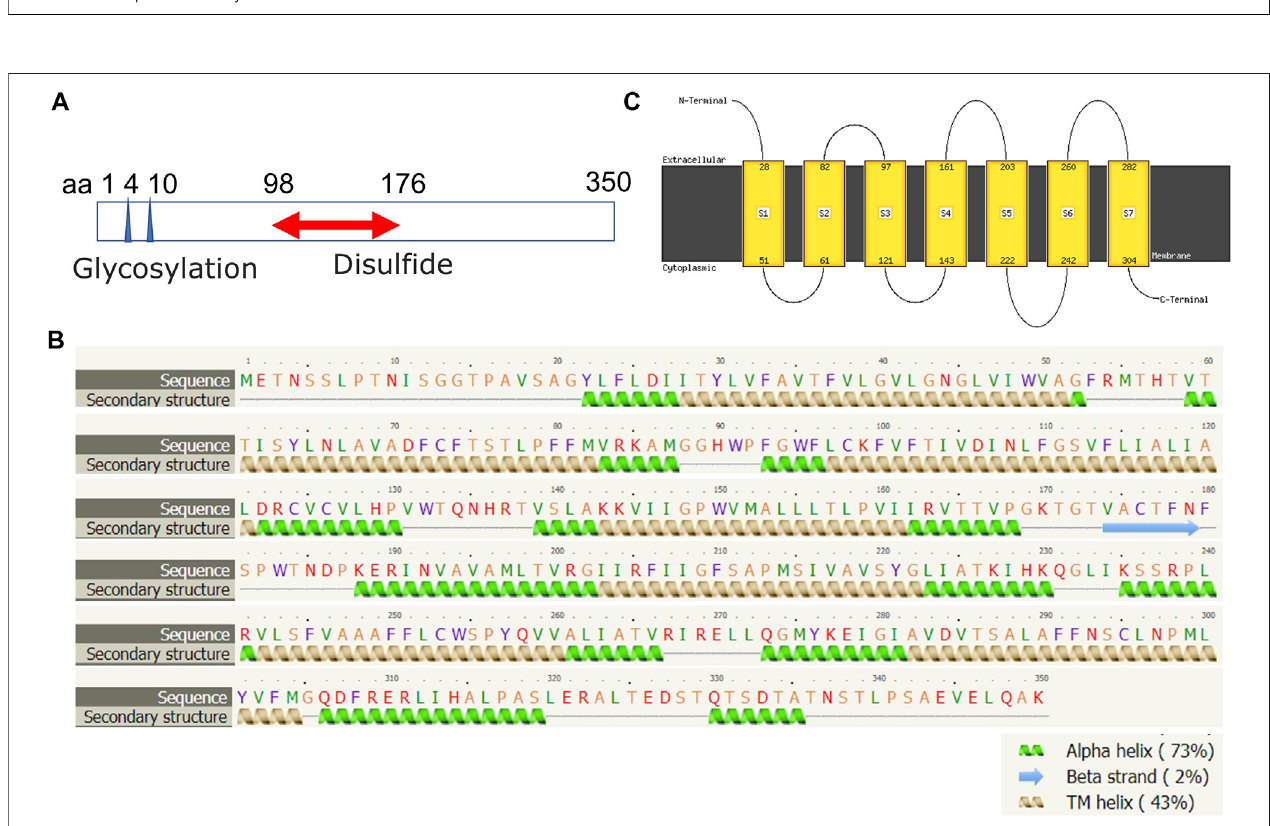
FIGURE7| MolecularstructuralanalysisofFPR1.MolecularstructureofFPR1,predictedbybioinformaticsinformationbasedon (A) Uniprot(https://www.uniprot. org/), (B,C) the Phyre2 web portal (http://www.sbg.bio.ic.ac.uk/phyre2/) all showing characteristics of G protein-coupled receptor.